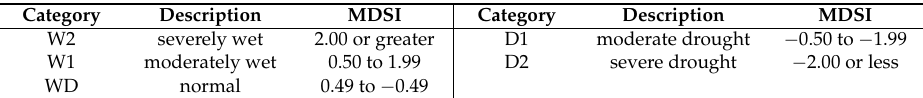
Table 4. Categories of wet (W), dry (D) and normal (WD) conditions of the MDSI